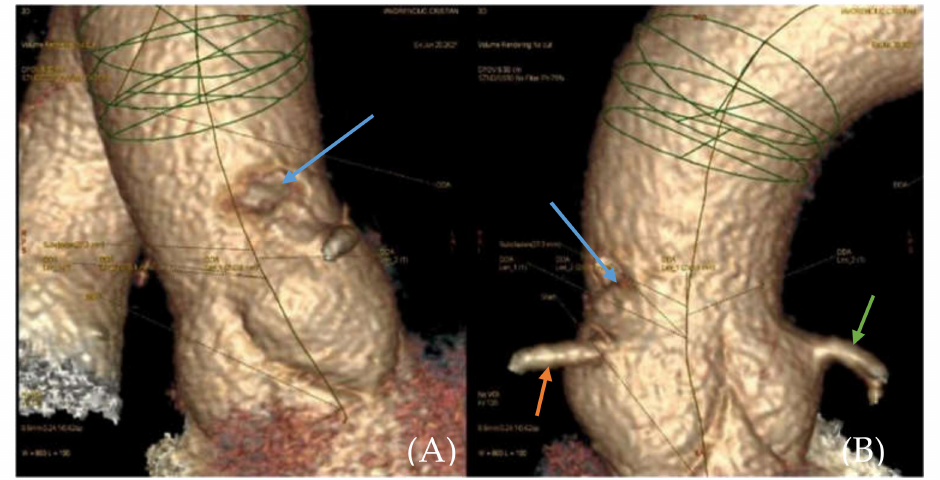
Figure 2. ( A , B ). 3D reconstruction of CTA(computed tomography angiography) image of the ascending aorta. Filling defect in the ascending aorta (blue arrow). Right coronary artery (orange arrow). Left coronary artery (green